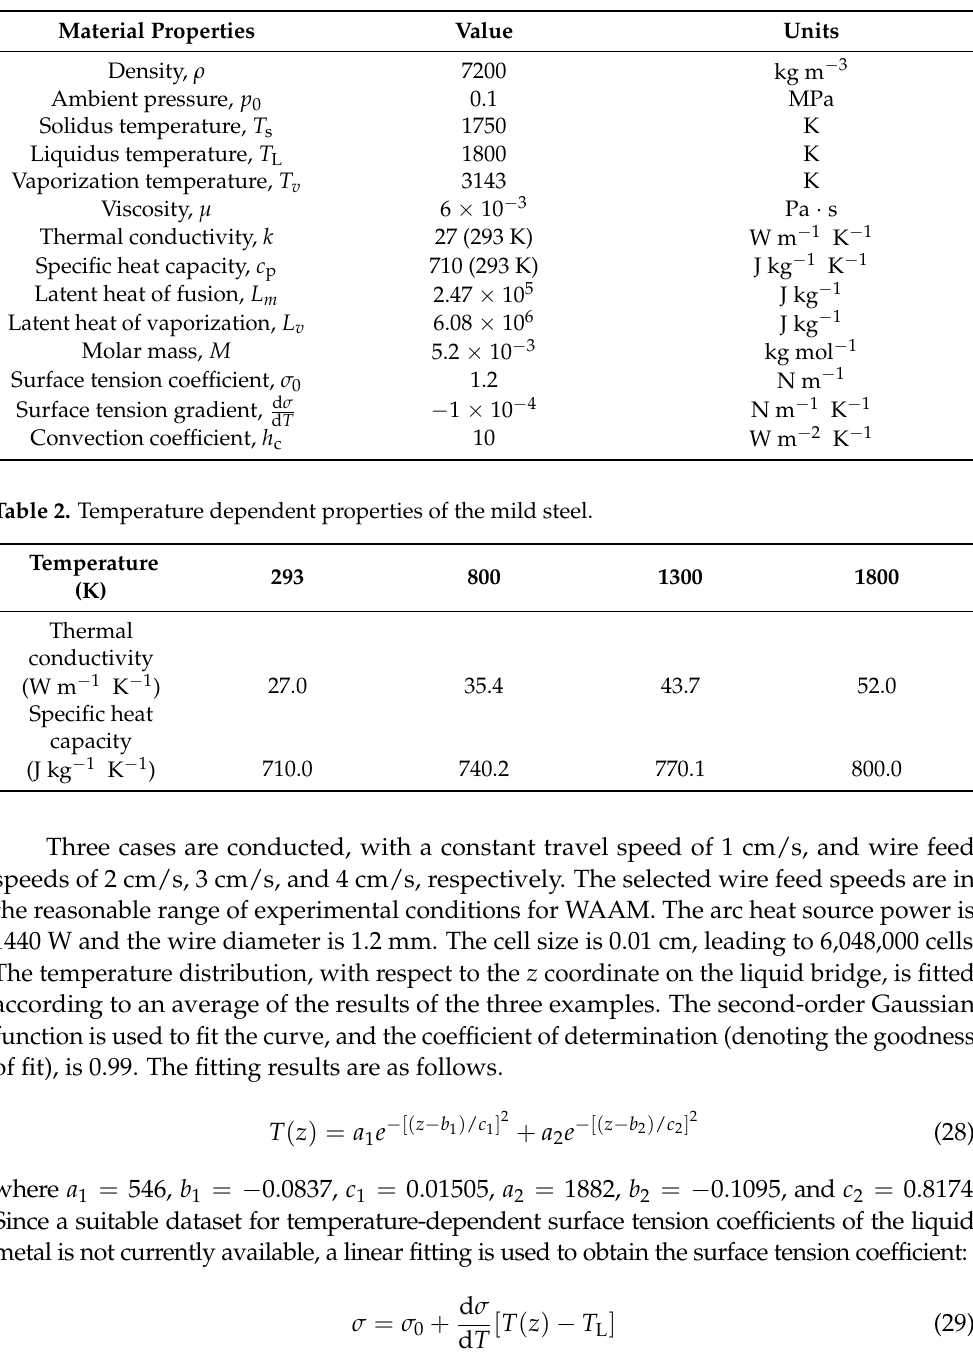
Table 1. Material properties of the mild steel.